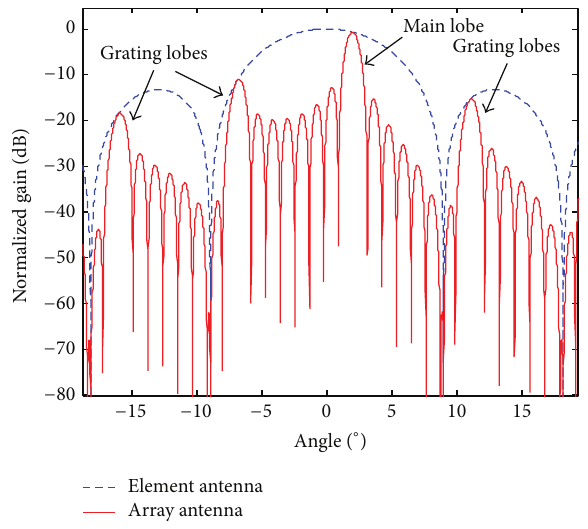
Figure 1: Array antenna pattern with a limited number of subaper-